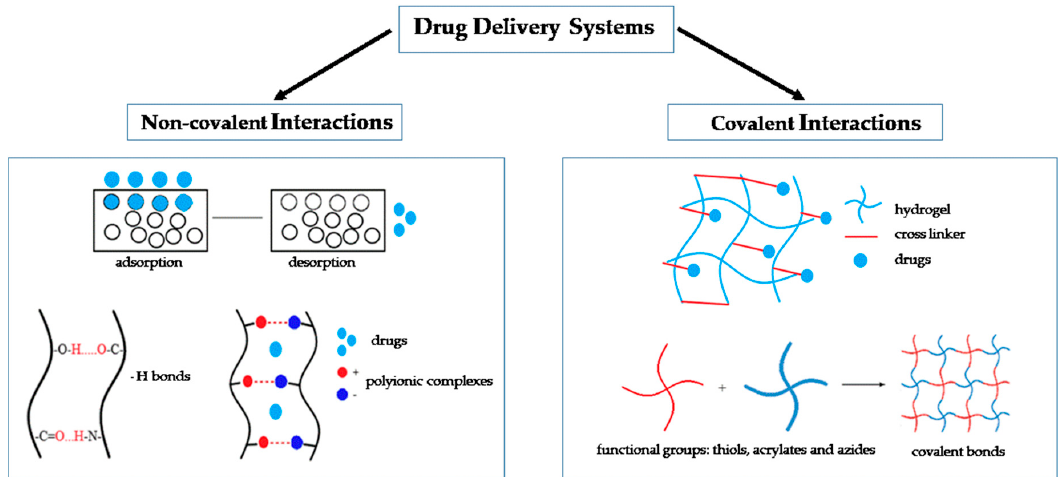
Figure 1. Types of drug delivery systems based on the method of interaction of a substance with a carrier-scaffold. Non-covalent interactions can be created through adsorption, H-bonds or polyionic complexes. Covalent interactions are the result of the formation of covalent bonds (between functional groups).